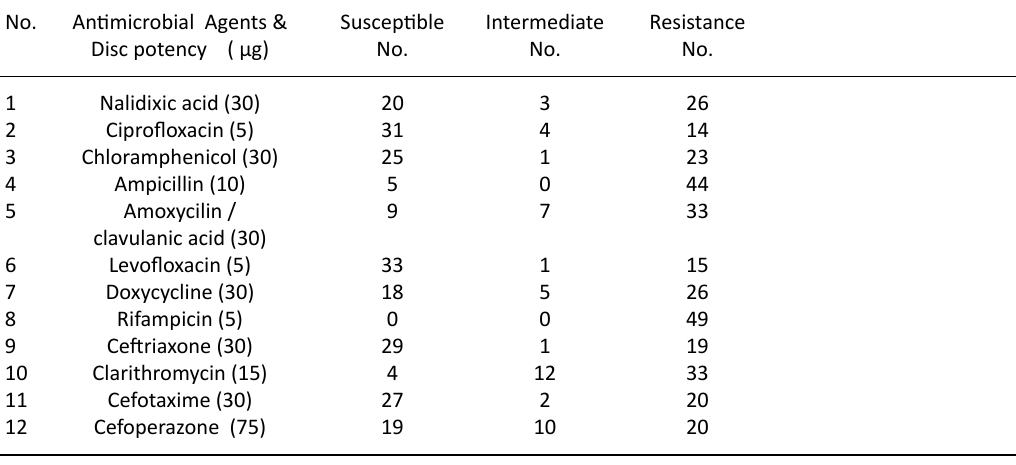
Table 2. Antimicrobial resistance profile of Enterobacterial isolates No. Antimicrobial Agents